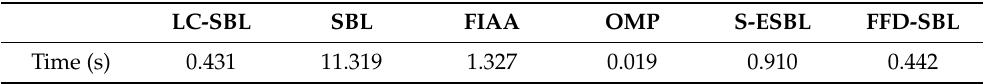
Figure 3. ( a ) Image model. Imaging results and azimuth profiles of 86 element radar ( b , c ), 516 element radar ( d , e ) and distributed radar system ( f , g ) obtained by using conventional SBL algorithm. Table 1. The average computational times of the OMP, FIAA, SBL, S-ESBL and LC-SBL algorithms with a 10 dB